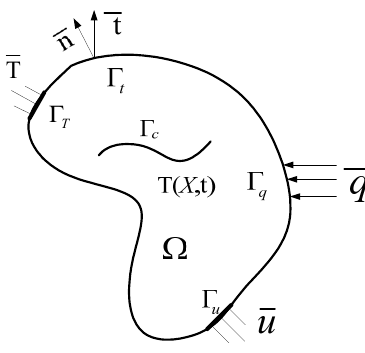
Figure 3. The thermo-elastic model of the structure caused by a crack during welding heat. t represents stress, u represents displacement, q